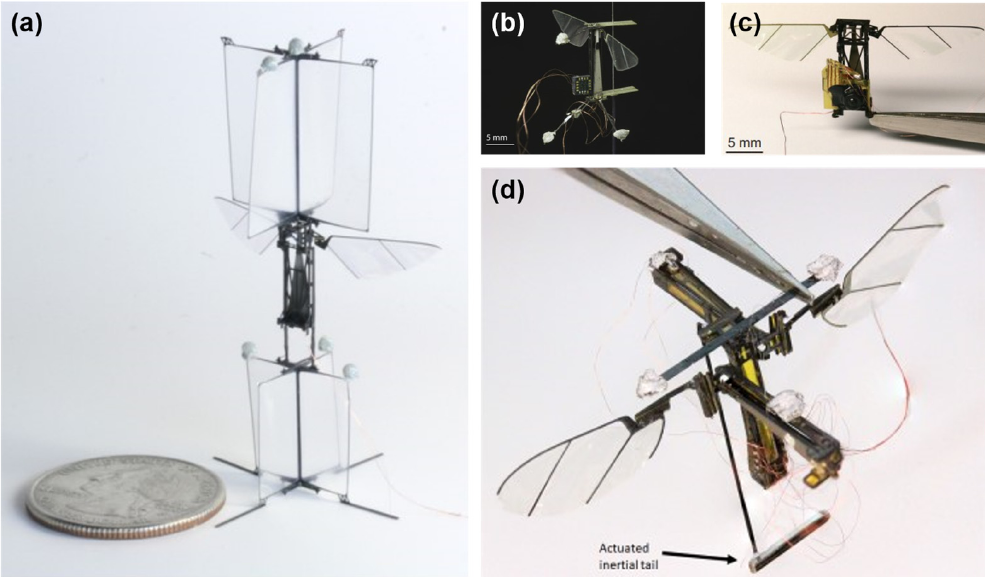
Figure 11. ( a ) RoboBee with aerodynamic damper. Reprinted with permission from Ref. [24]. Cop- yright 2012, IEEE. ( b ) RoboBee with onboard magnetometer. Reprinted with permission from Ref.